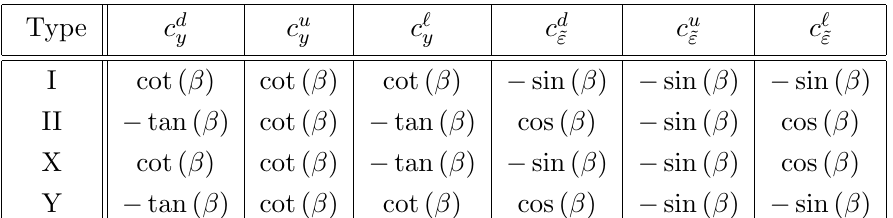
of the Higgs basis and the new parameters ~ " F ij = c F y f (cid:14) ij + ~ " F =c F . The ~ " F break the Z 2 symmetry of the four y ij ij ij ~ " i